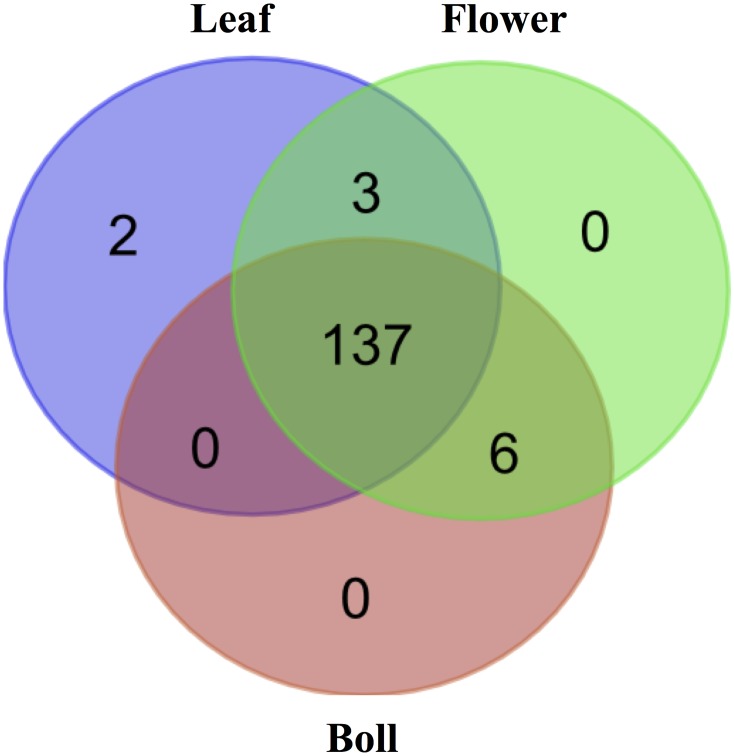
Comparison of differentially expressed miRNAs and isomiRNAs among the three tissues examined.Venn diagram shows the number of differentially expressed miRNAs and isomiRNAs among the three tissue types, leaf, flower and boll as indicated.